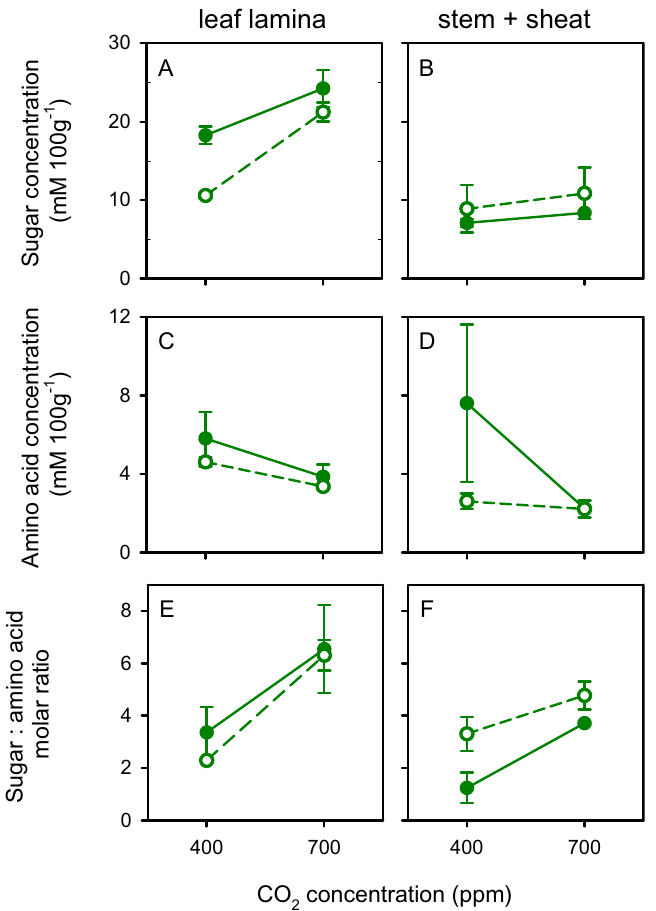
Figure 3. Effects of nitrogen (high: closed symbol, low: open symbol), [CO 2 ] and their interaction on the concentration of sugars and amino acids on wheat plants at 49 days after sowing, immediately after the completion of aphid assay 3. ( A , B ) Total sugars, ( C , D ) total amino acids, ( E , F ) sugar: amino acid molar ratio in ( A , C , E ) leaf lamina and ( B , D , F ) stem + sheath. Error bars are two standard errors of the